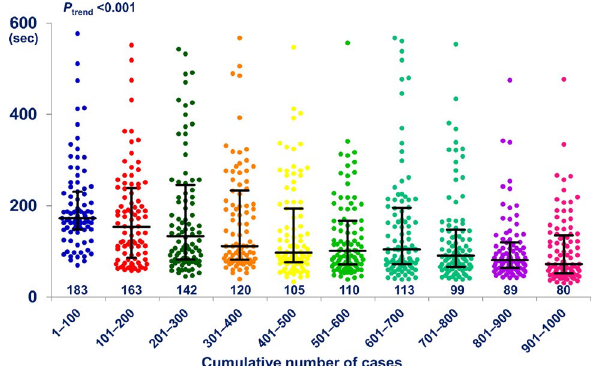
Figure 3. Trend analysis of median distal radial access time showing significantly decreasing from 183 s in 1–100 patients to 80 s in 901–1000